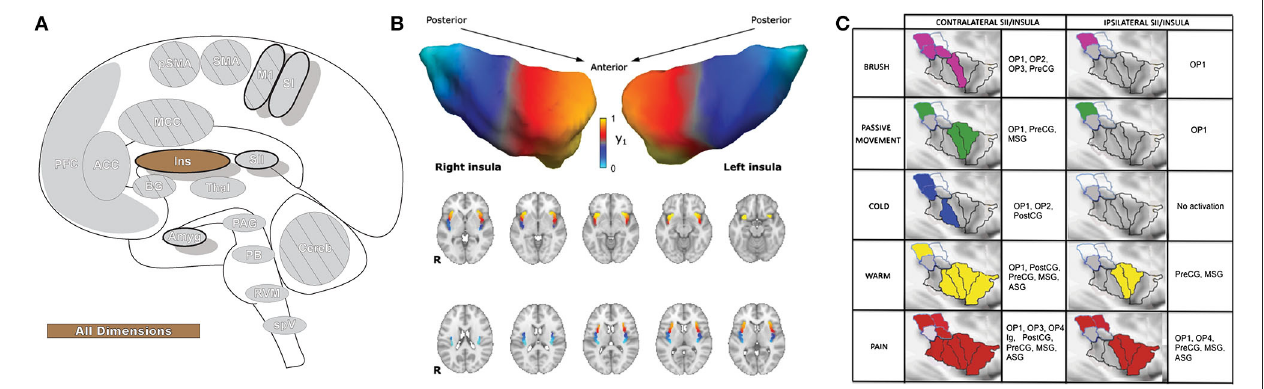
FIGURE 6 | Insular cortex. (A) Brain areas active during pain: insula (Ins) highlighted. (B) Topographic organization of connectivity (anatomical and FC) of the insula and other brain regions is arranged along a rostro-caudal gradient wherein anterior insular regions show strong connections to the anterior cingulate cortex, dorsolateral prefrontal cortex, and inferior parietal lobules (red) and the posterior insula with somatosensory regions and the parietal operculum (blue). Similarities in connectivity profiles in adjacent insular regions suggest that, rather than discrete subunits, the topographic distribution of connections is better appreciated as a spatially continuous and gradually changing gradient. Displayed as a gradient in graph form, this type of spatial connectivity analysis is referred to as a connectopy map. FC,functional connectivity- temporally synchronized low-frequency fluctuations in BOLD signal between regions that indicate they are connected in their functions. Such areas may or may not have direct anatomical connections. Reprinted from Nature: Scientific Reports, Vol 22(1), D Vereb, B Kincses, T Spisak, F Schlitt, N Szabo, P Farago, K Kocsis, B Bozsik, E Toth, A Kiraly, M Zunhammer, T Schmidt-Wilcke, U Bingel, ZT Kincses, Resting-state functional heterogeneity of the right insula contributes to pain sensitivity, p22945, Copyright (2021) Vereb et al., under the Creative Commons Attribution License (CC-BY). DOI: https://doi.org/10. 1038/s41598-021-02474-x. (C) Operculo-insular areas (including insula and SII) respond to a wide variety of somatosensory, and painful, stimuli. Anatomically defined region of interest analyses with fMRI indicate varied functional overlap/segregation between a variety of stimuli delivered to the left hand. Reprinted from NeuroImage, Vol 60(1), L Mazzola, I Faillenot, FG Barral, F Mauguiere, R Peyron, Spatial segregation of somato-sensory and pain activations in the human operculo-insular cortex, p409–18., Copyright (2012), with permission from Elsevier. DOI: https://doi.org/10.1016/j.neuroimage.2011.12.072. PreCG,precentral insular gyrus; ASG,anterior short gyrus; MSG,middle short gyrus; posterior- PostCG,postcentral insular gyrus; Ig1,insular lobe granular area 1; Ig2,insular lobe granular layer 2; Id1,insular lobe dysgranular area 1; SII subunits: OP1, OP2, OP3, OP4 (OP, operculum